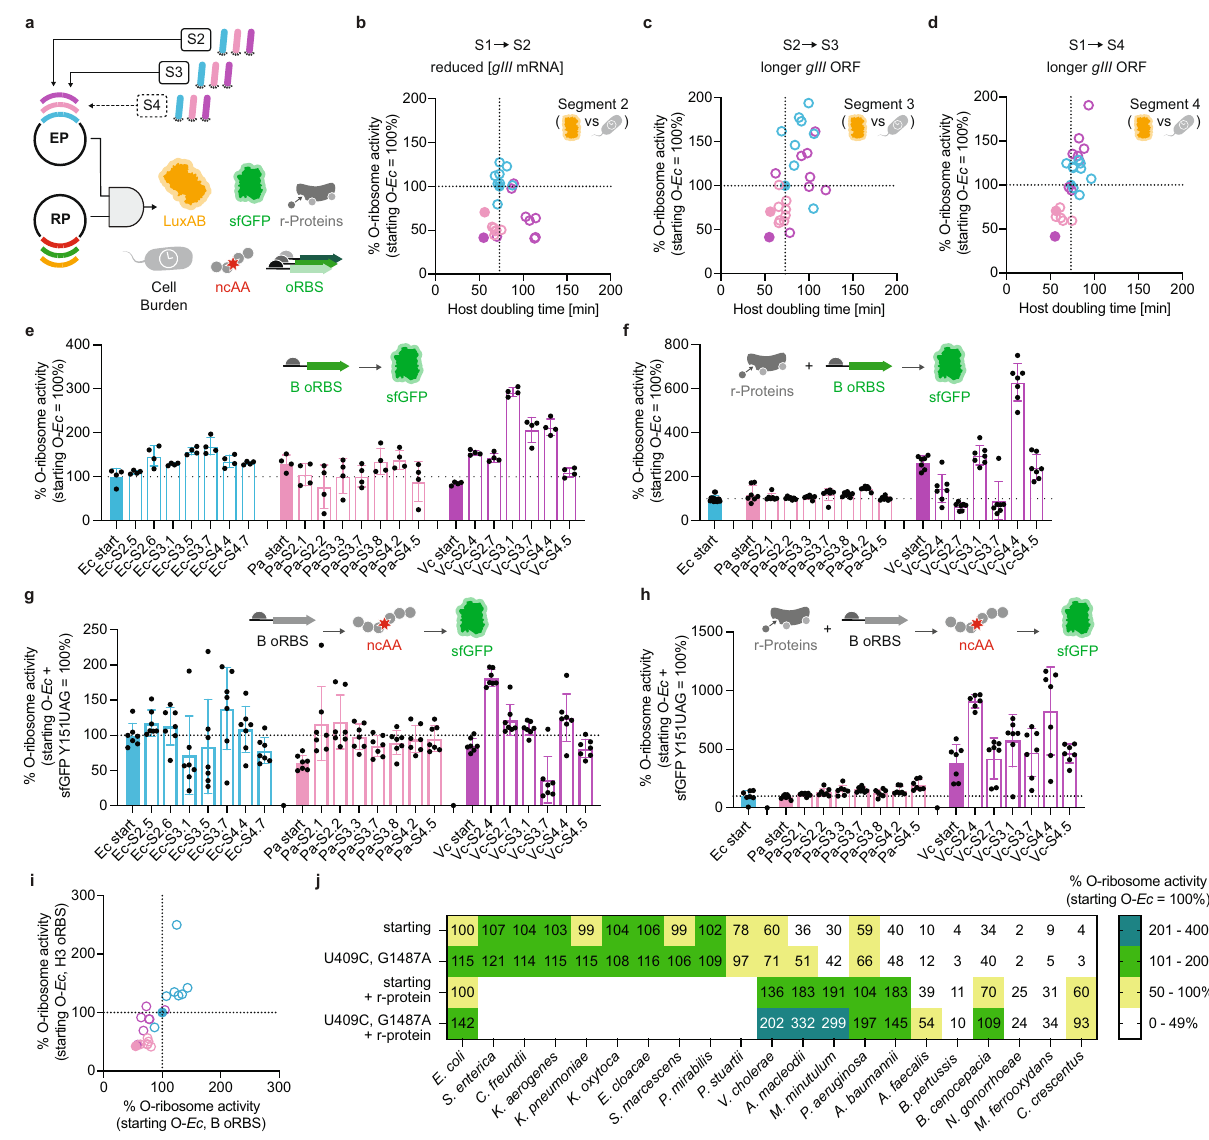
Fig. 5 In-depth characterization of evolved o-ribosome activities. a o-rRNA variants from each oRibo-PACE segment were cloned into expression plasmids (EPs) and tested alongside reporter plasmids (RPs) of variable genes, RBSs, and context dependencies. Luminescence activity calculated at OD 600 = 0.15 plotted against host strain (S3489) doubling time is shown for o-rRNA variants derived from each species corresponding to selections; b S1 → S2, c S2 → S3, and d S1 → S4. Data re fl ect a mean of 1 – 72 biological replicates ( n = 1 – 72). Select o-rRNA variants were prioritized based on luminescence activity and evaluated for sfGFP production in the absence ( e ) or presence ( f ) of cognate heterologous ribosomal proteins (r-proteins). Incorporation of the ncAA BocK for select variants in the absence ( g ) or presence ( h ) of cognate heterologous r-proteins. Data re fl ect mean and standard deviation of 4 – 7 biological replicates ( n = 4 – 7). i sfGFP yield through orthogonal translation and using either the B or H3 o-RBS show comparable activities in most cases. j Consensus mutations U409C and G1487 discovered through oRibo-PACE were incorporated into rRNAs derived from phylogenetically divergent bacterial species, and evaluated for sfGFP production in the presence or absence of cognate heterologous r-proteins. In all cases, data are normalized to the activity of the starting E. coli o-rRNA activity. Starting rRNAs are shown as fi lled in bars or circles, whereas evolved variants are shown as borders only. Data re fl ect the mean and standard deviation of 1 – 72 biological replicates. Where relevant, data are normalized to the activity of the starting E. coli o-rRNA activity (dashed line). Starting rRNAs are shown as fi lled in bars or circles, whereas evolved variants are shown as borders only. Colors blue ( E. coli ), pink ( P. aeruginosa ), and purple ( V. cholerae ) are consistent across plots. Source Data are available in the Source Data